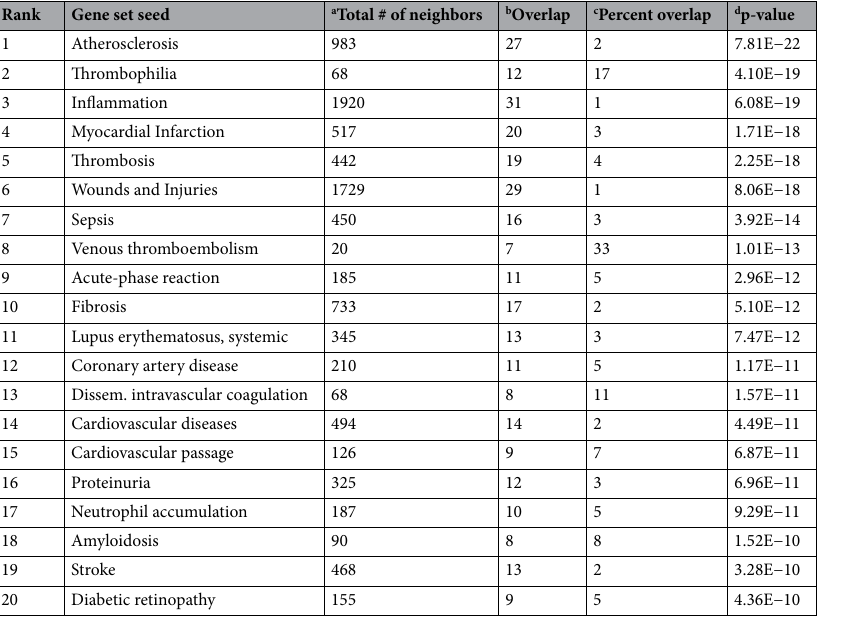
Table 3. Subnetwork enrichment pathways for serum proteins obtained from manatees exposed to red tide. a The number of proteins in the specified pathway for human proteins. b The number of proteins from the data set that matched proteins in the pathway. c The calculated percent of proteins in the data set divided by the proteins in the human set times 100. d The probability that the pathway is